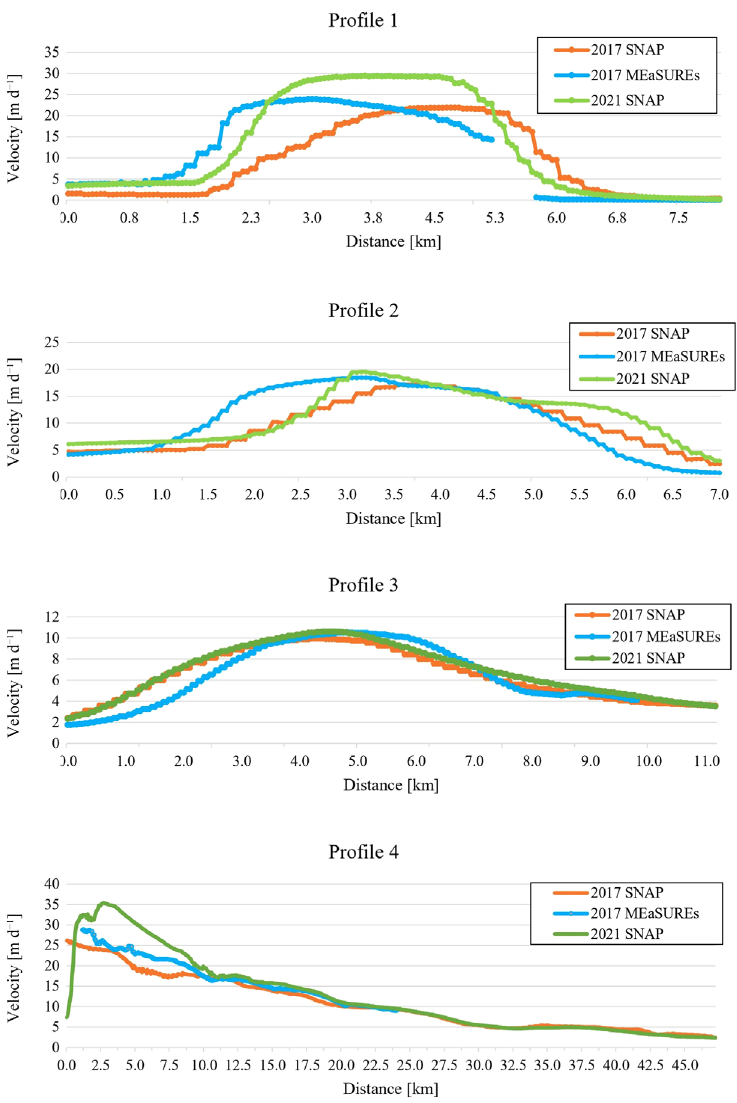
Fig. 10. Winter profiles presenting velocity